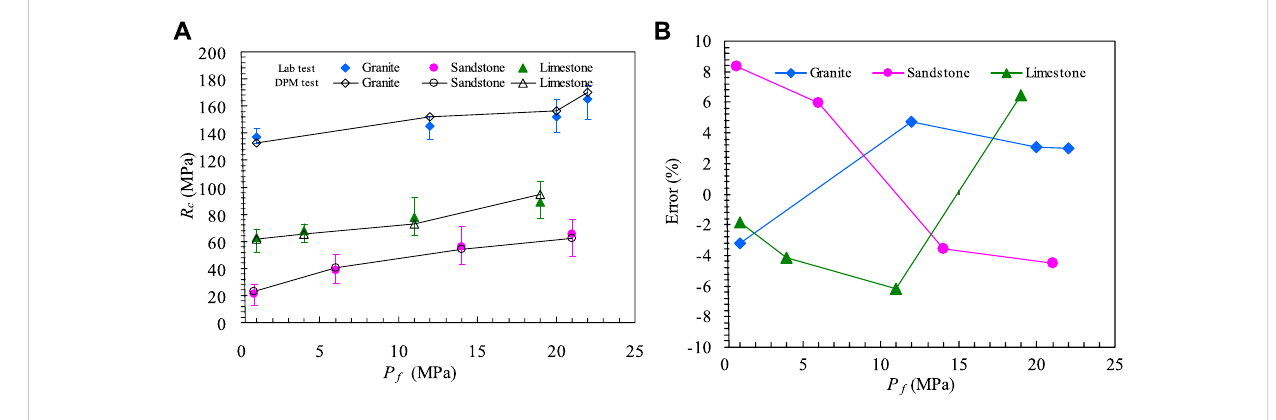
FIGURE 7 The obtained results for the strength of sandstone, limestone and granite from the drilling tests. (A) the strength result (B) the strength error.